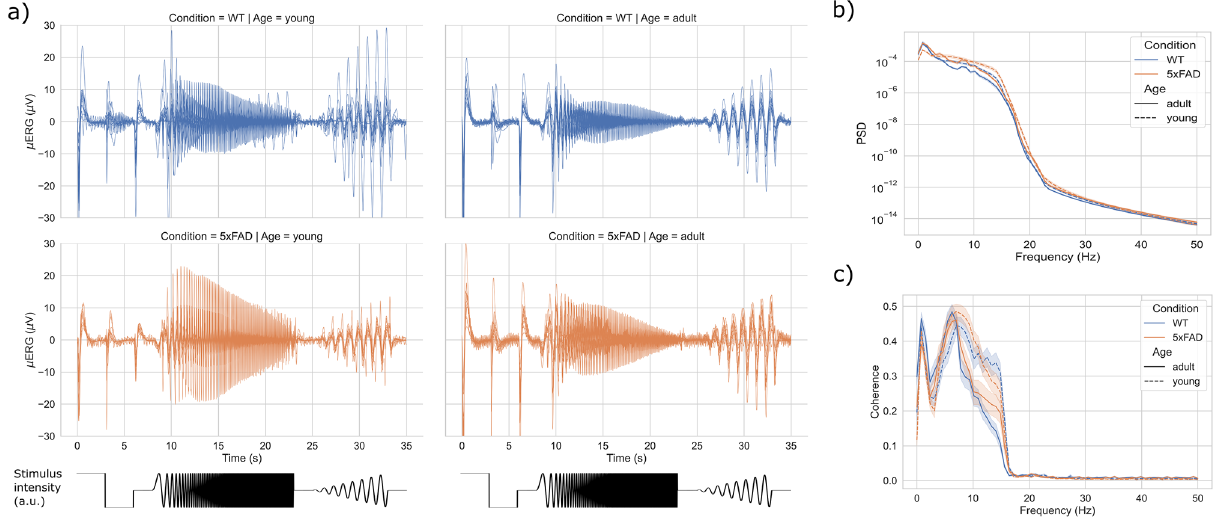
Figure 2. Time- and frequency-domain characteristics of µ ERG responses during the chirp stimulus (CS) protocol. ( a ) µ ERG responses during the CS protocol for all retinas separated by condition and age. For reference, the stimulus intensity is shown on the bottom. ( b ) Average power spectral density (PSD) of the µ ERG responses. ( c ) Coherence between the light stimulus and the µ ERG response for the CS protocol. Shaded areas indicate 95% confidence